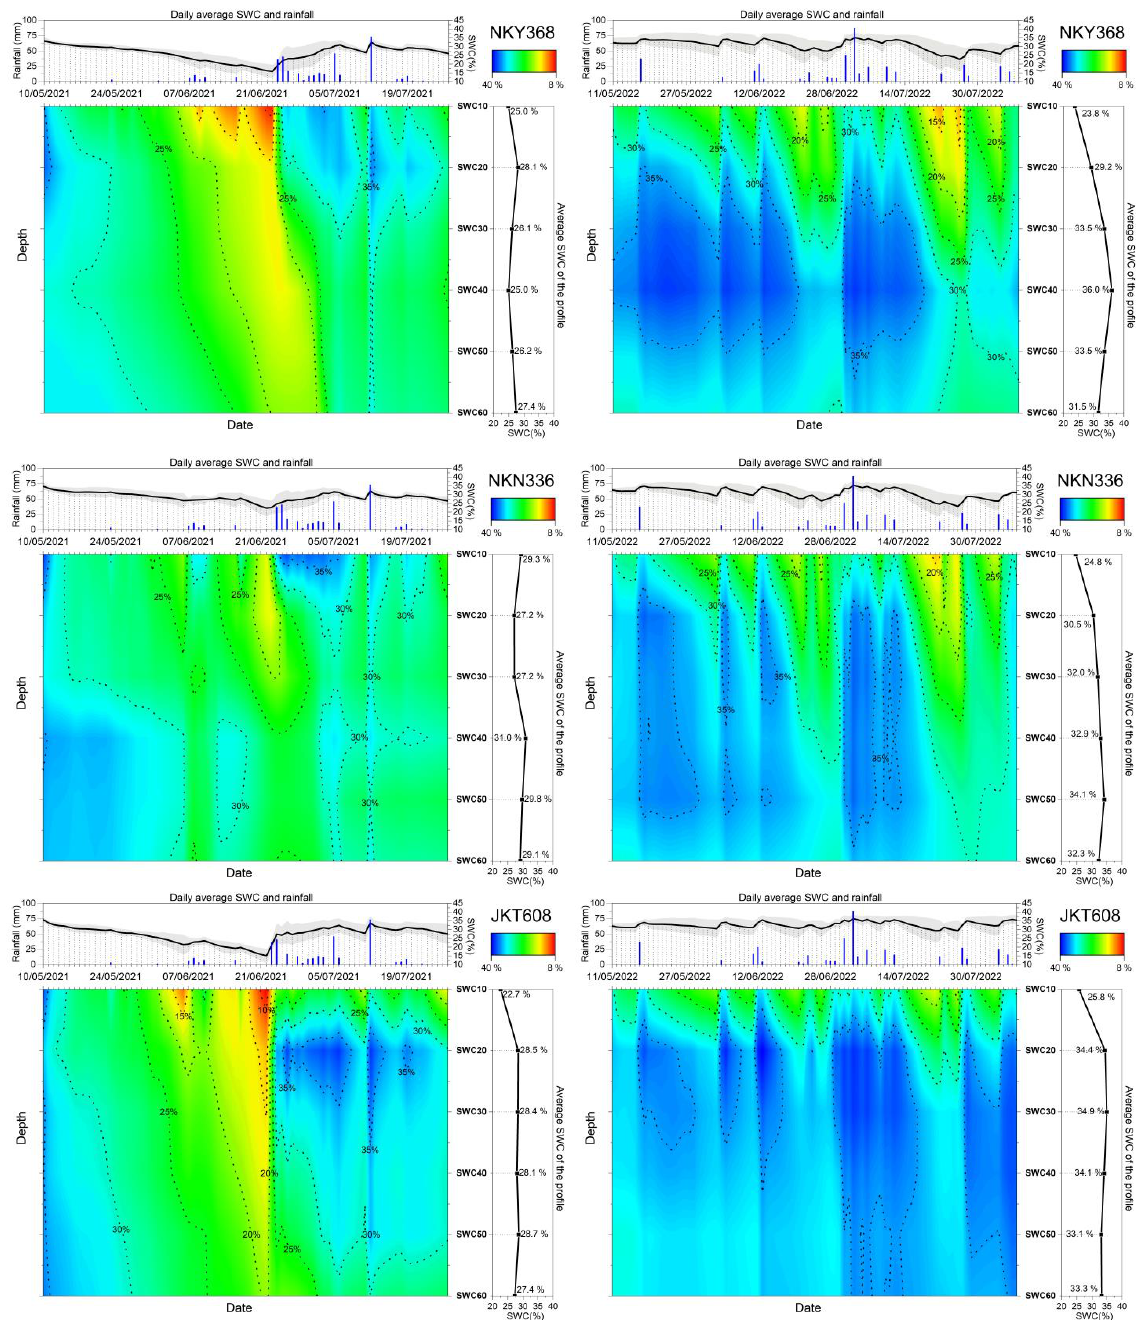
Figure 5. Processes and statistical characteristics of changes in the soil water content (SWC) in the root zone profiles of different